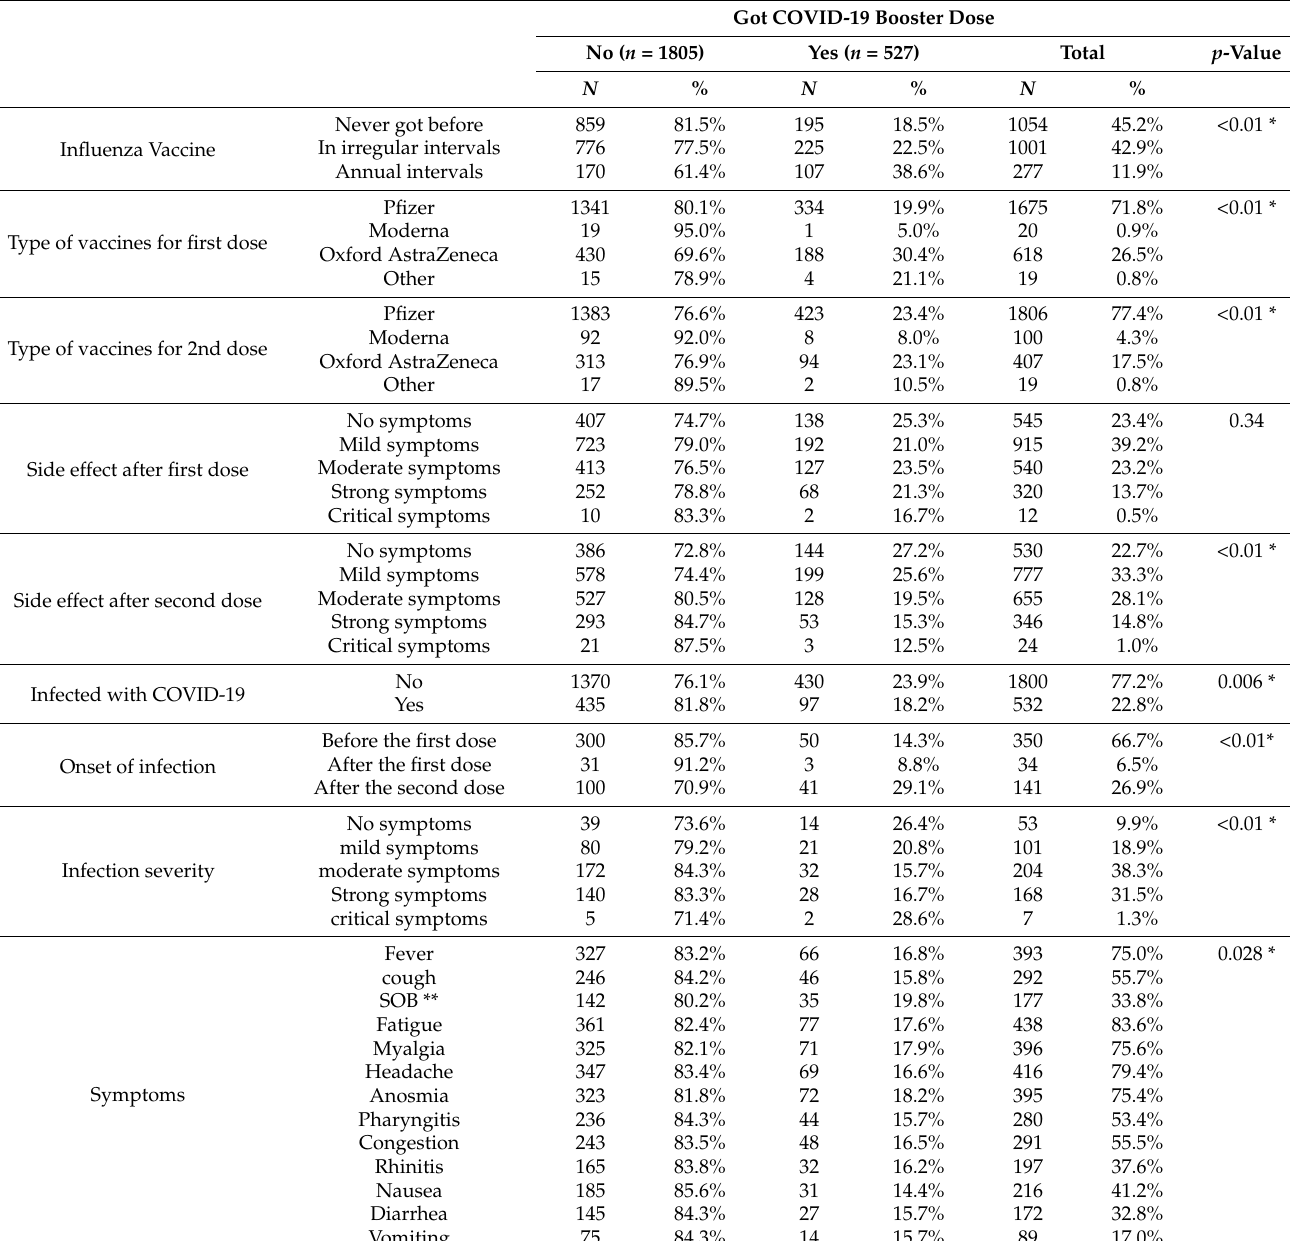
Table 2. Vaccine history and infection history among study’s